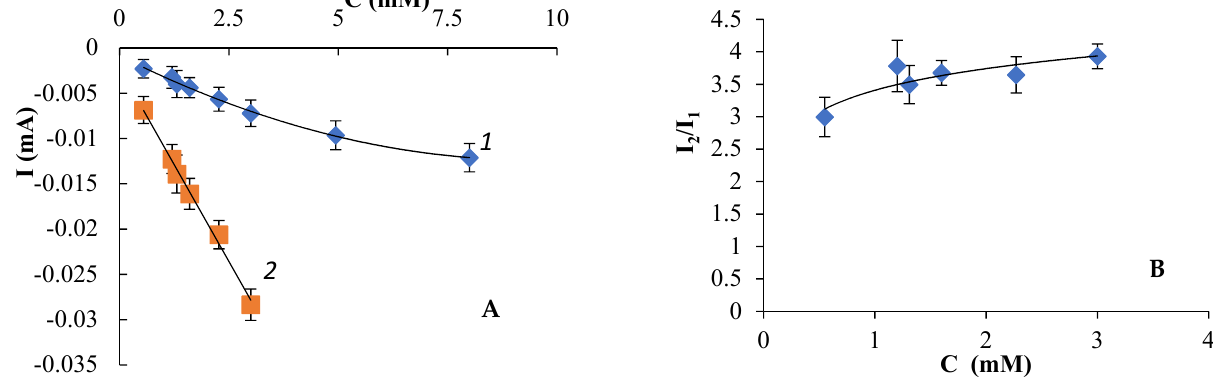
Figure 5. ( A ) The values of the current on the CVA of compound 1a at the potentials of the first (1) and second (2) stages versus concentration. ( B ) Change in the ratio of currents at the potentials of the second and first stages (I 2 /I 1 ) from the concentration of 1a . v = 100 mVs − 1 .